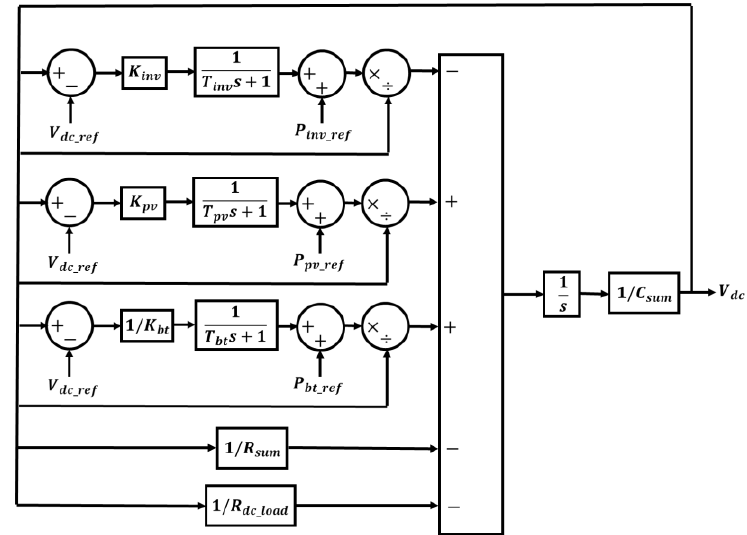
Figure 19. The control diagram of a small-scale hybrid microgrid.